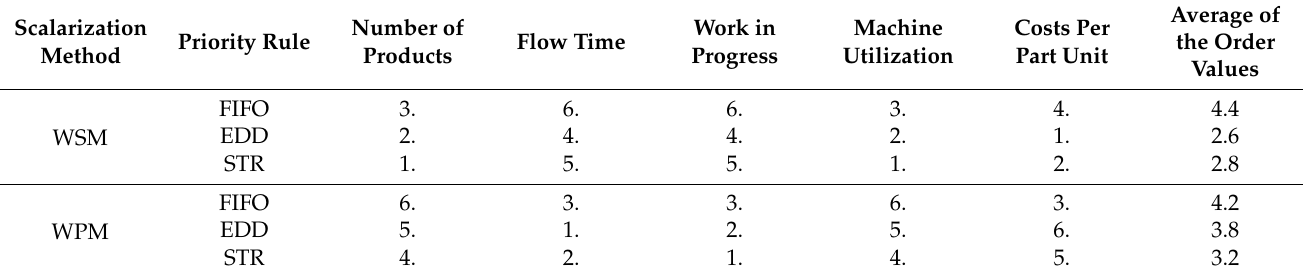
Table 9. The individual ordering production goals values according to the results of multi-criteria optimization. Scalarization